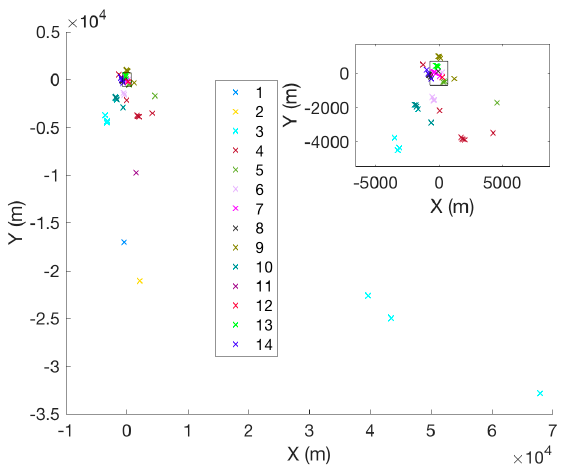
Figure 3. The number and location of buoys used for comparison to radar-based wave statistics for the various radar datasets (see legend and Table 2). The points mark the buoy positions at the start of radar data collection for each dataset. The black box denotes the analysis region used in this study, and the inset shows a zoom-in of the area near the analysis region.